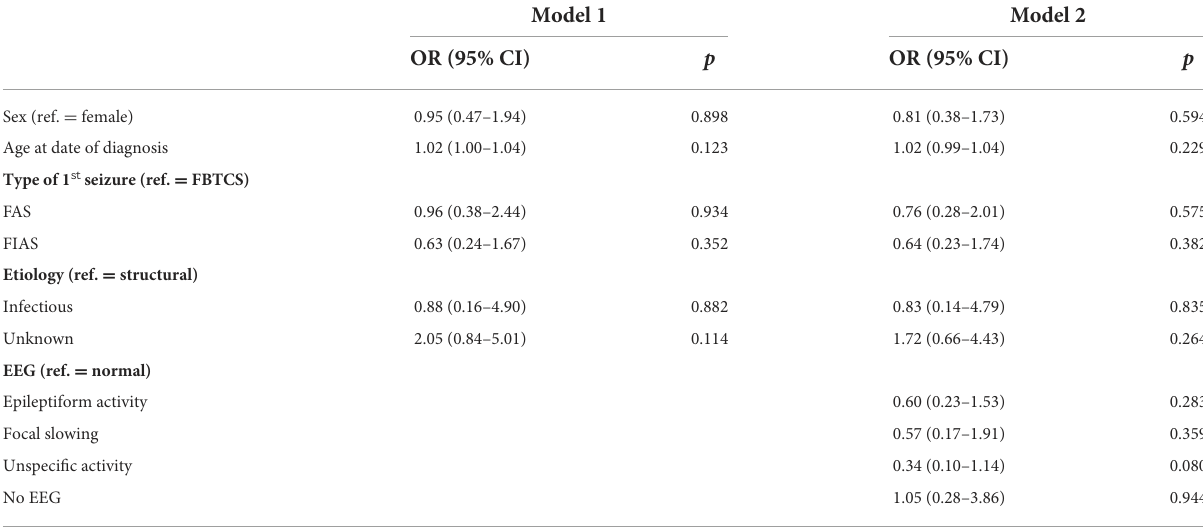
TABLE 3 Odds ratios and 95% confidence intervals and p values from the logistic regression models for seizure freedom after second or subsequent antiseizure medications in patients with focal